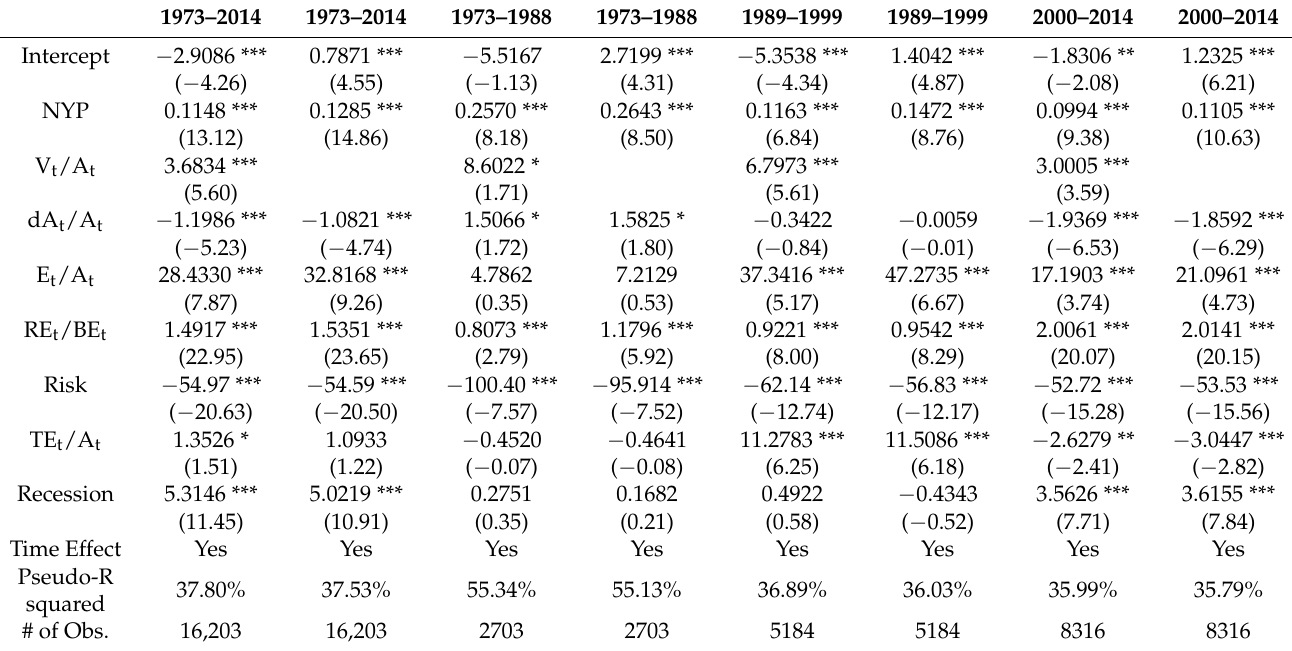
Table 5. Logit regressions with additional variables. This table provides results of logit regressions of the determinants of the likelihood a bank will pay dividends. The dependent variable equals one in year t if the bank pays dividends in year t and zero otherwise. The independent variables are: Profitability (E t /A t ), growth rate of assets (dA t /A t ), percentile of market capitalization in NYSE firms (NYP), and market-to-book ratio (V t /A t ). Other variables from the literature are also added. T-statistics are reported in the parentheses. ***, **, and * indicate statistical significance at the 1%, 5%, and 10% level,